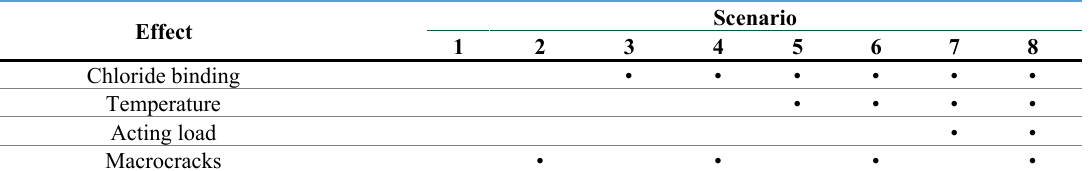
Table 2. Effects considered in each scenario.